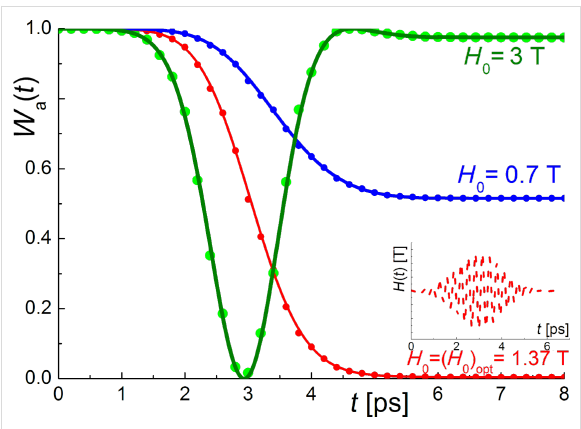
Figure 2: The dynamics of the ground level population, W a , of an atomic system (µ 12 = 10µ 0 , ω 12 ≈ 2·10 13 Hz, a 0 = 1, b 0 = 0) for the case of an oscillating Gaussian magnetic field pulse ( ω l = ω 12 , t 0 = 3 ps, τ = 1 ps). The filled circles are the numerical calculations and the solid lines are the analytical approaches described using Equation 7 and Equation 8. The magnetic field acting on the system is presented in the inset (dashed